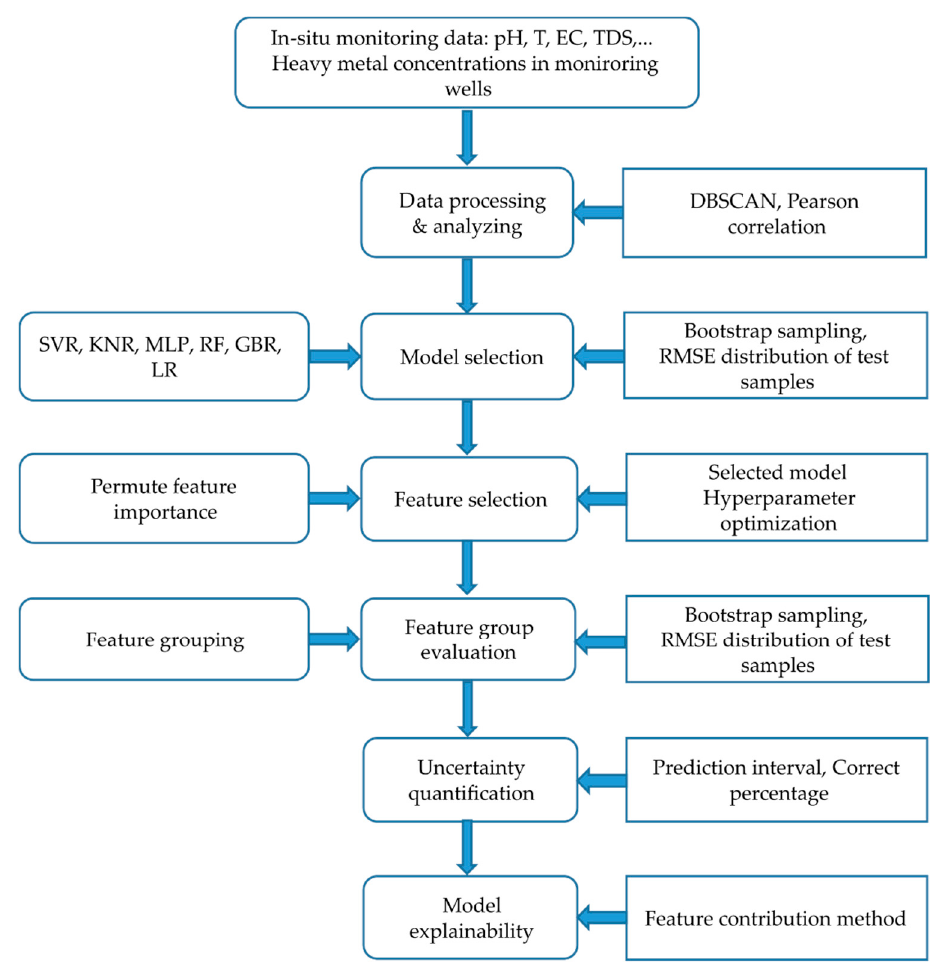
Figure 1. A Conceptual research framework.